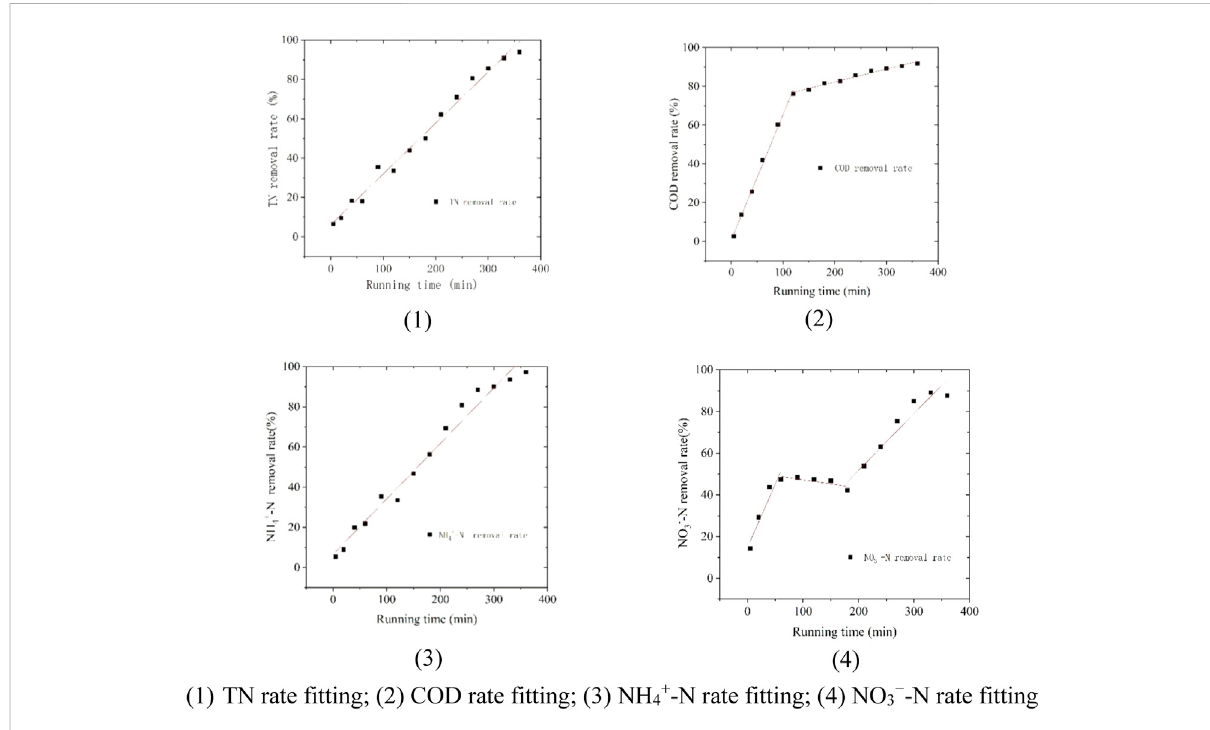
FIGURE 4 Carbon and nitrogen removal rates of the combined sewage treatment system. 1) TN rate fi tting; 2) COD rate fi tting; 3) NH 4 + -N rate fi tting; 4) NO 3 − -N rate fi